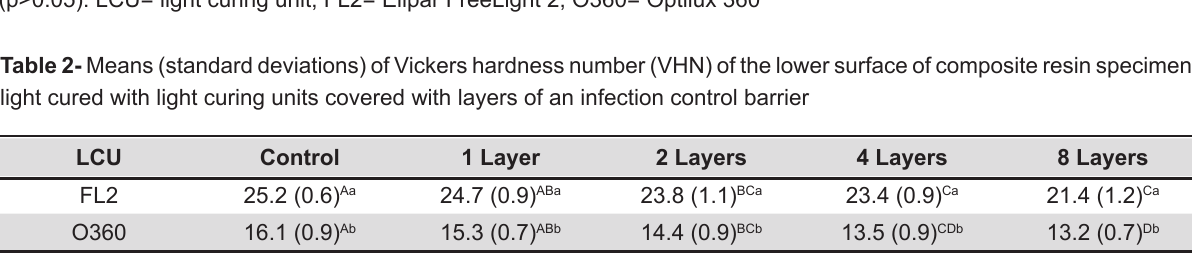
Values having the same capital letters in the rows and the same small letters in the columns are not statistically significant